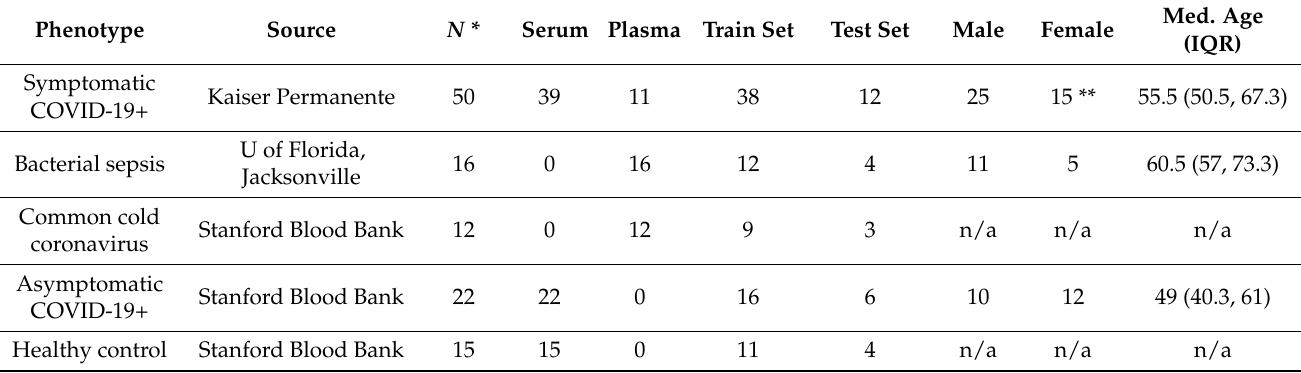
Table 1. Cohort summary, to the extent annotations were